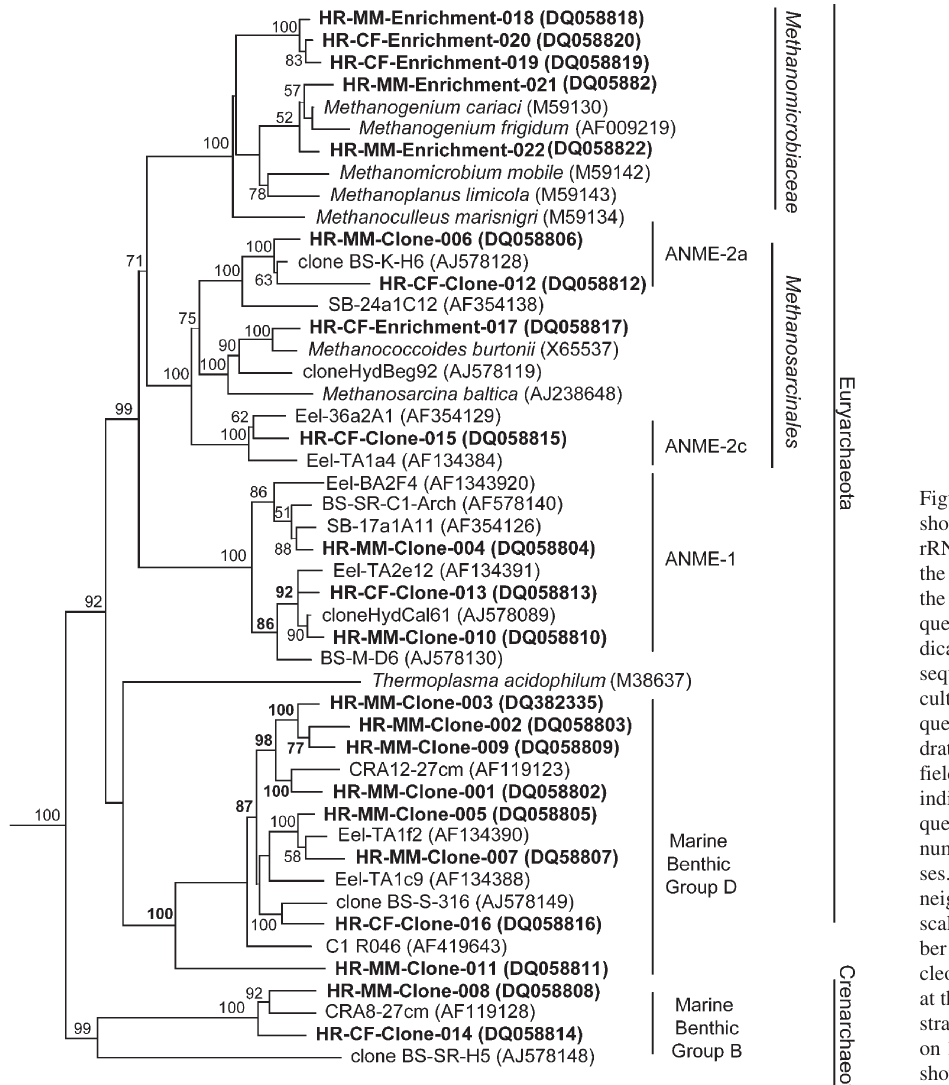
Figure 1. Phylogenetic tree showing the affiliations of 16S rRNA gene sequences from the enrichment cultures and the clone sequences. Se- quences from this study are in- dicated by bold-face type; sequences from enrichment cultures are identified. Se- quences are labeled HR (Hy- drate Ridge) and CF (clam field) or MM (microbial mat) indicate the source of the se- quences. GenBank accession numbers are listed in parenthe- ses. The tree was calculated by neighbor-joining analysis. The scale bar represents the num- ber of fixed mutations per nu- cleotide position. The numbers at the branch nodes are boot- strap percentage values based on 1000 iterations and are shown for branches with more than 50% bootstrap